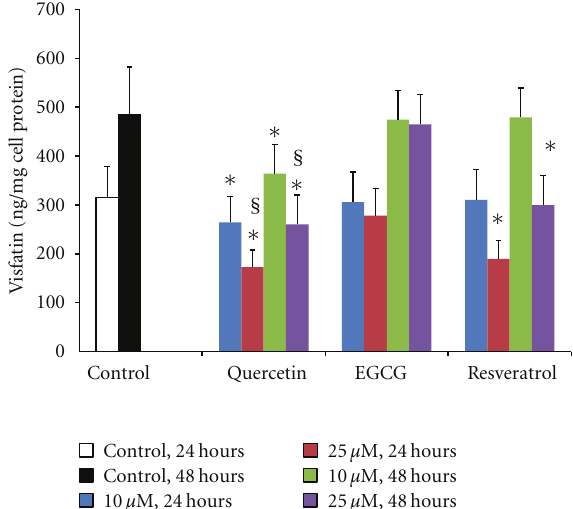
Figure 2: E ff ect of polyphenols quercetin, epigallocatechin gallate (EGCG), and resveratrol on visfatin secretion by human mature SGBS adipocytes at 24 and 48 hours. Cells were cultured in medium and incubated with 10 or 25 mM of quercetin, EGCG, and resveratrol for 24 and 48 hours. Visfatin levels were determined in the cell supernatant by commercially available methods. Values represent the mean ± SD. ∗ P < 0 . 05 compared with corresponding control, § P < 0 . 05 compared with the value obtained at 10 μ